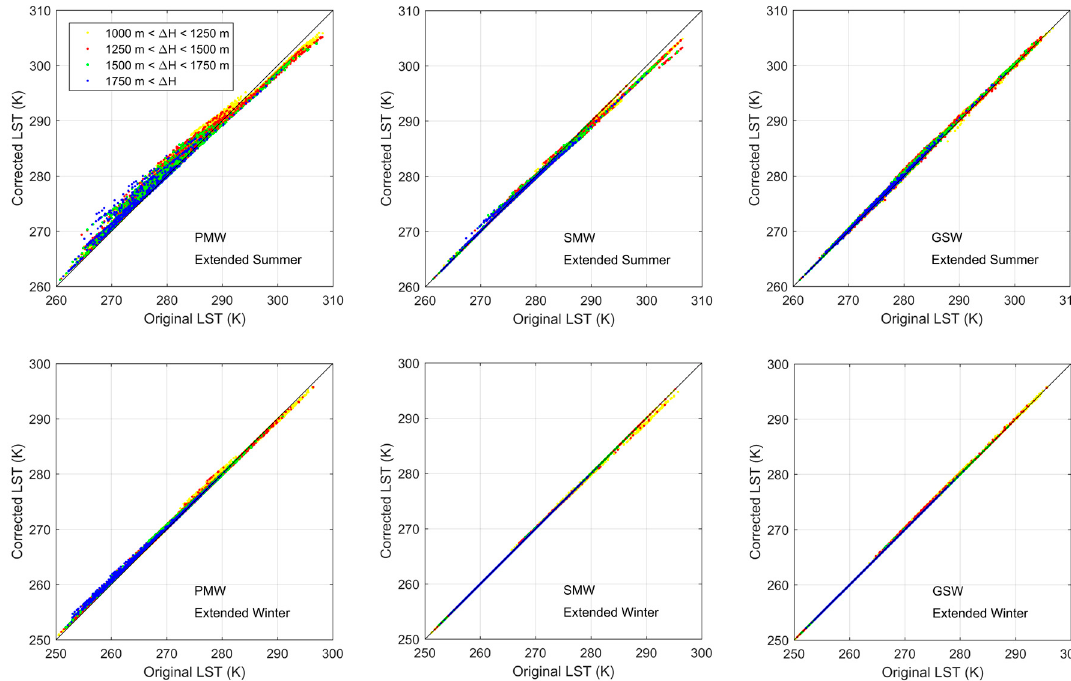
Figure 7. Scatterplots of corrected versus original values of retrieved LST for the four different classes of ∆ H (yellow, red, green and blue dots) when PMW ( left panels ), SMW ( middle panels ), and GSW ( right panels ) retrieval algorithms are applied during extended summer ( top panels ) and extended winter ( bottom panels ).